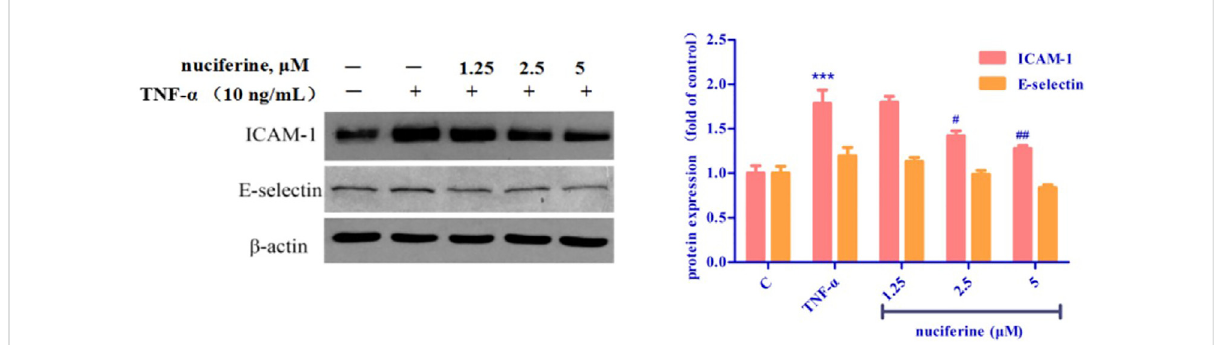
FIGURE 14 Effect of nuciferine on TNF- α -induced expression of adhesion molecules in HUVECs. (* p < 0.01 and *** p < 0.001 vs. control